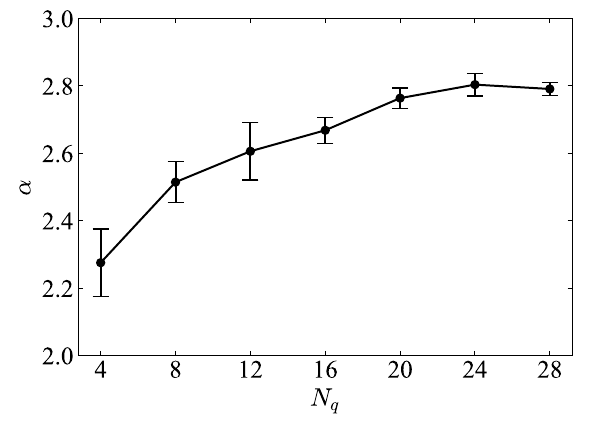
FIG. 13. Exponents α in Eq. (18) for different N q . The noise model is the same as that adopted in Sec. VIII C, where the average error rate for two-qubit gates is ε 2 =